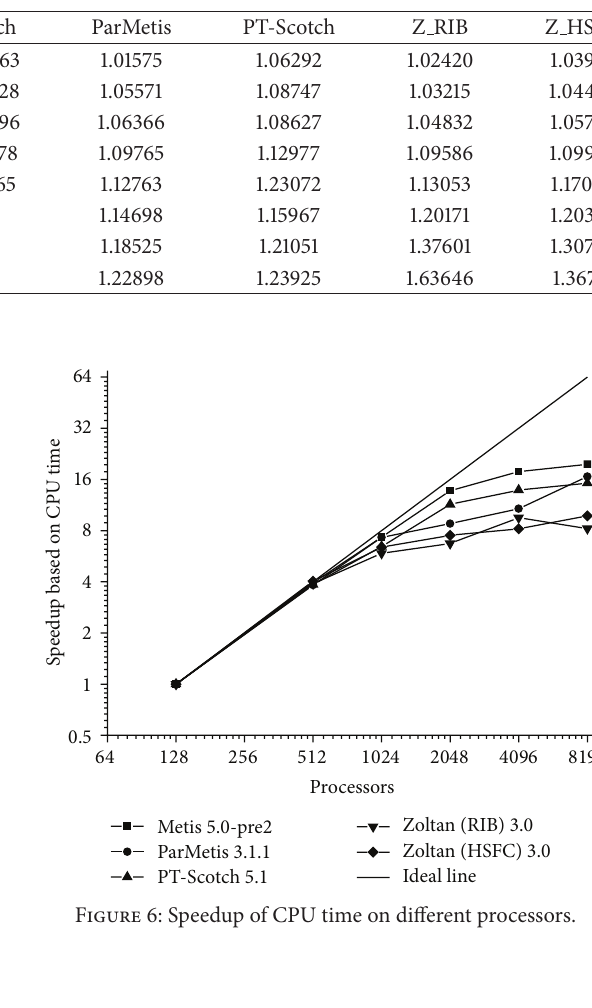
Table 2: Load imbalance under different processors.